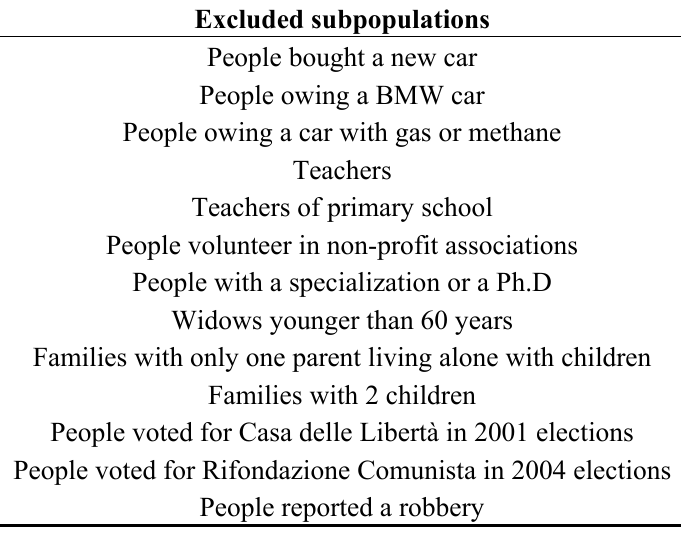
Table 2. Subpopulations excluded from the analysis using the algorithm based on the regression